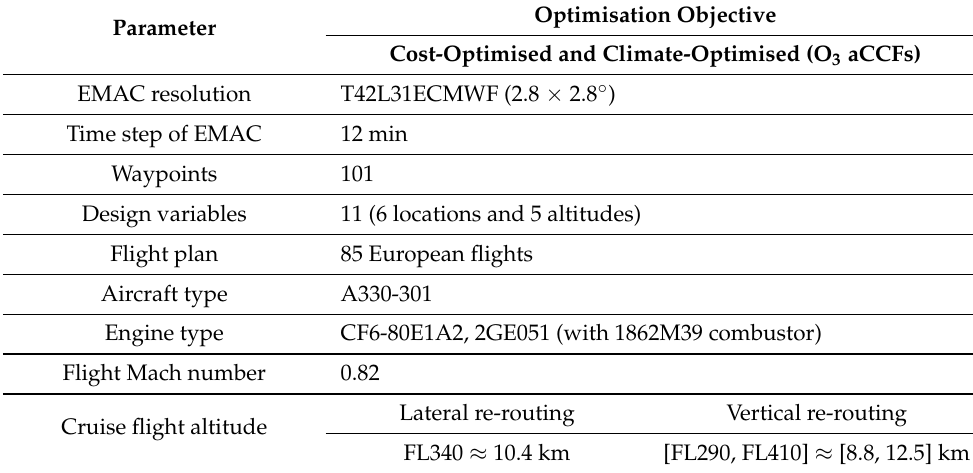
Table 2. One-day air traffic simulation